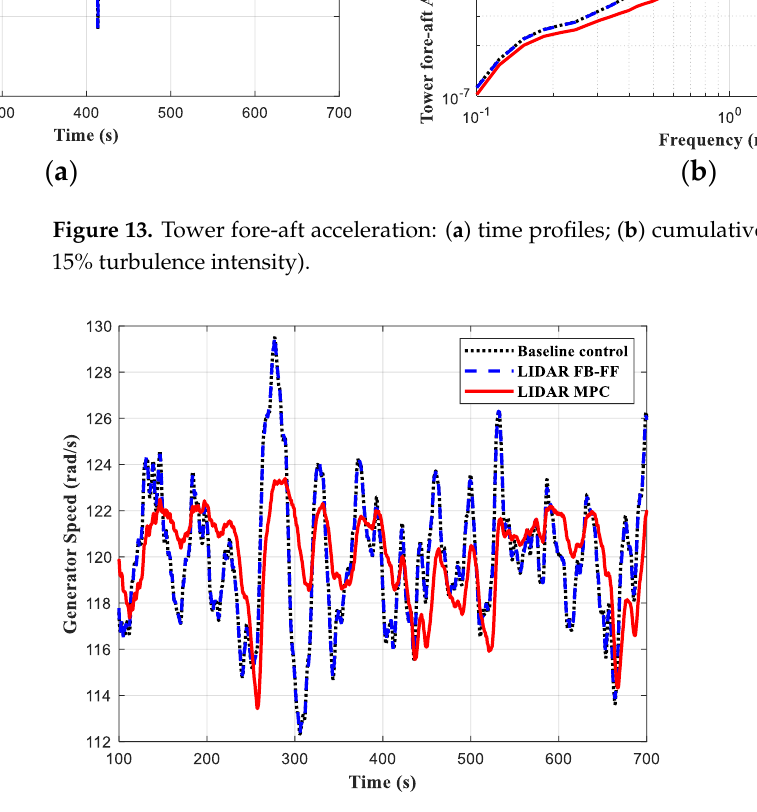
Figure 14. Comparison of the generator speed (wind speed with 15% turbulence intensity). Table 5. Performance statistics for a wind speed with 15% turbulence